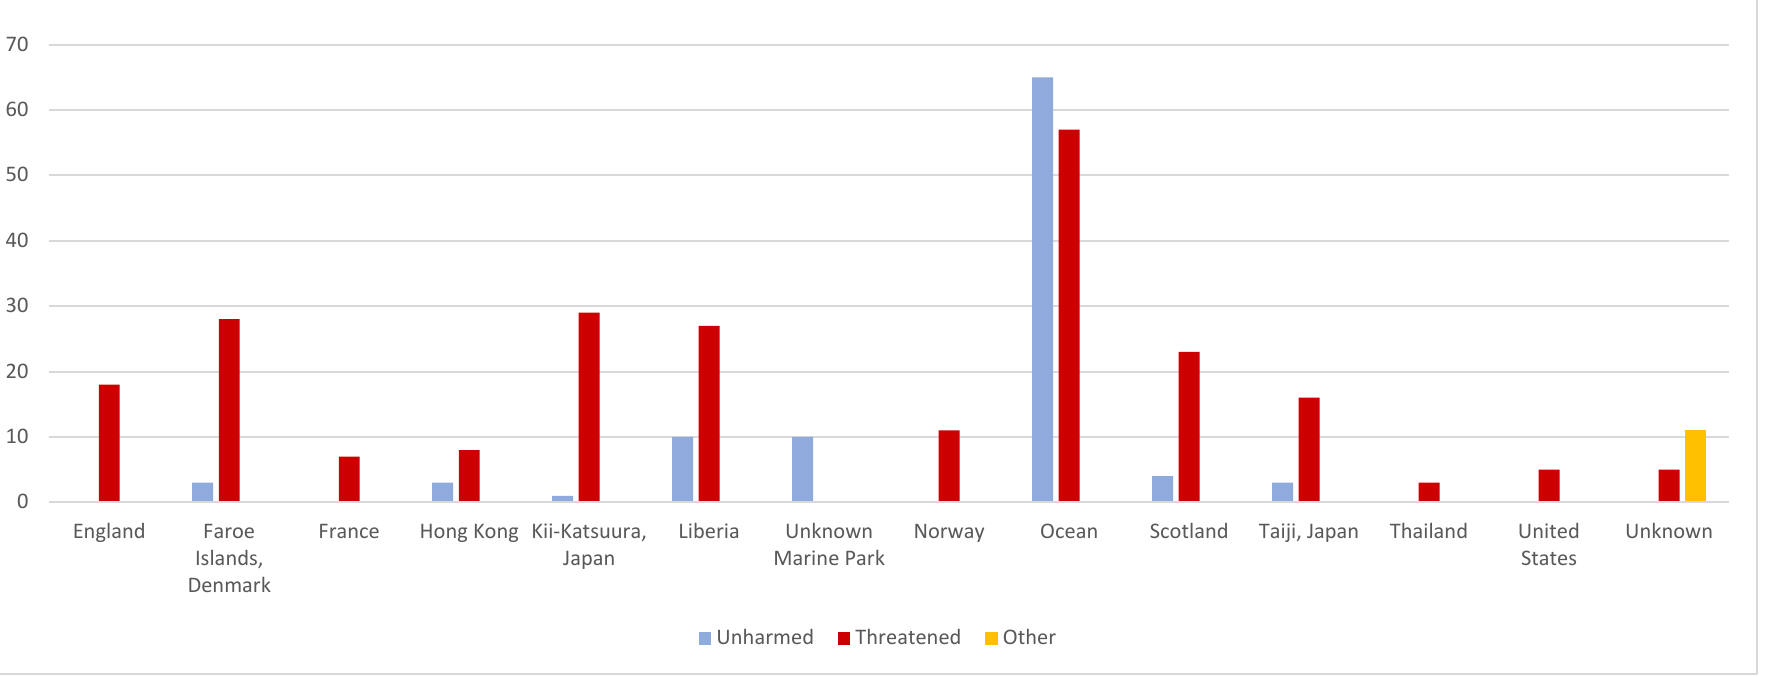
Figure 2. Seaspiracy’s Animal Imagery.